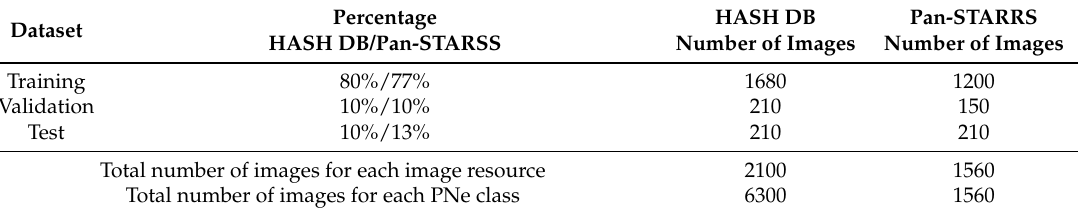
Table 2. Dataset distribution for True and Rejected PNe from the HASH DB and